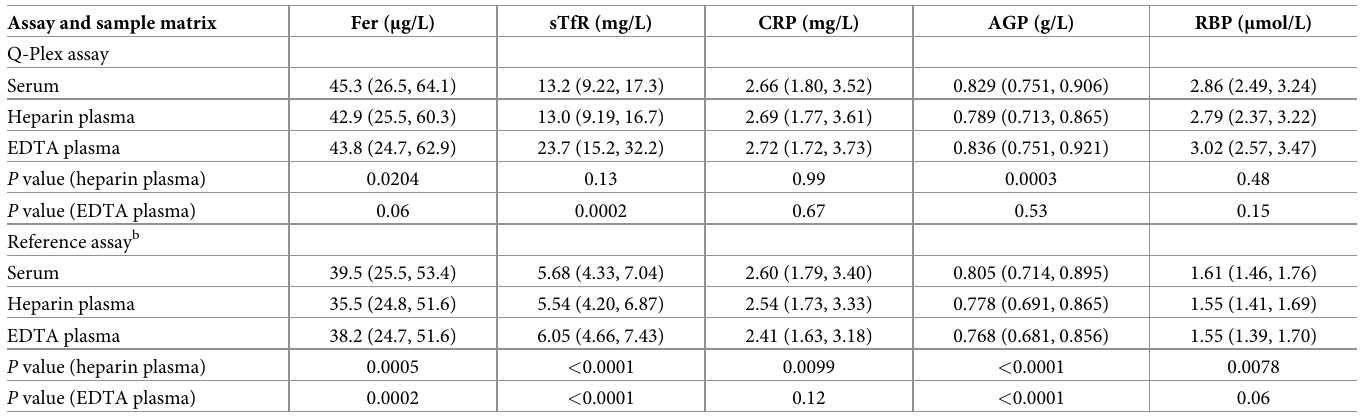
Table 6. Q-Plex and reference assay results for matrix-matched samples a . Assay and sample